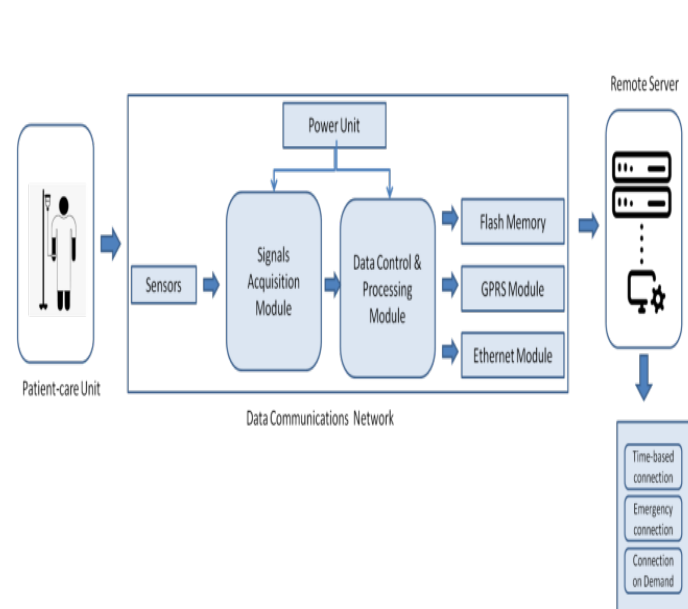
Figure 4. Data Acquisition and Processing